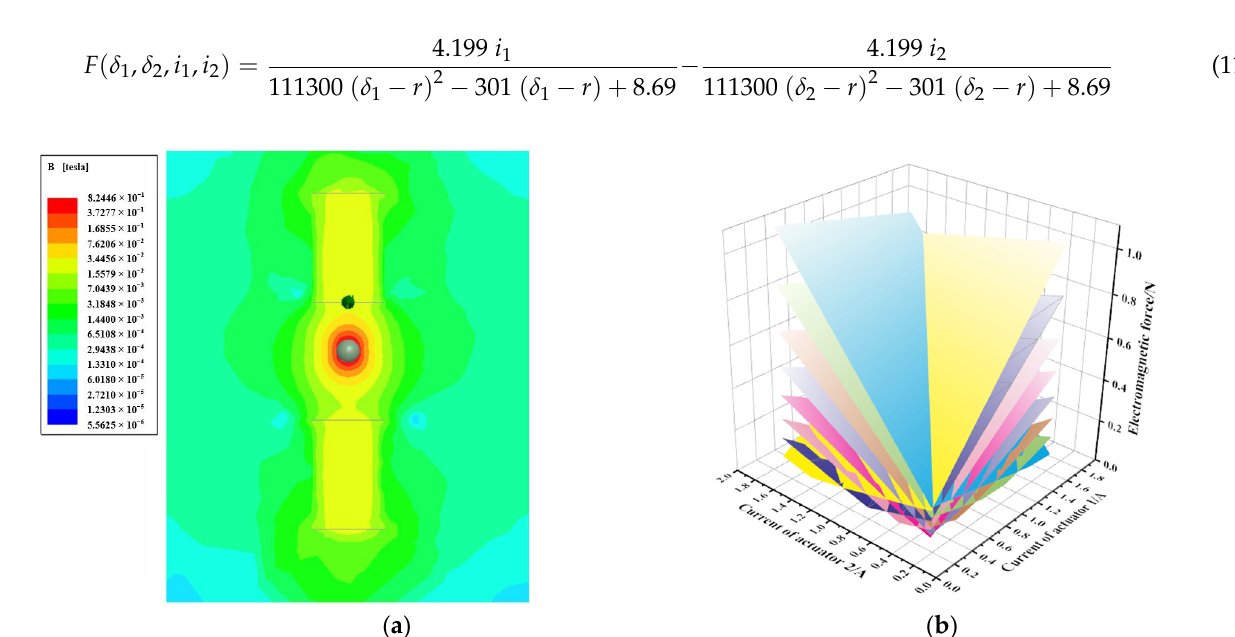
Figure 5. External magnetic field simulation and data fitting of the magnetic levitation actuation and motion control system. ( a ) ANSYS Maxell magnetic field simulation of dual electromagnetic actuators; ( b ) Data fitting of electromagnetic force.